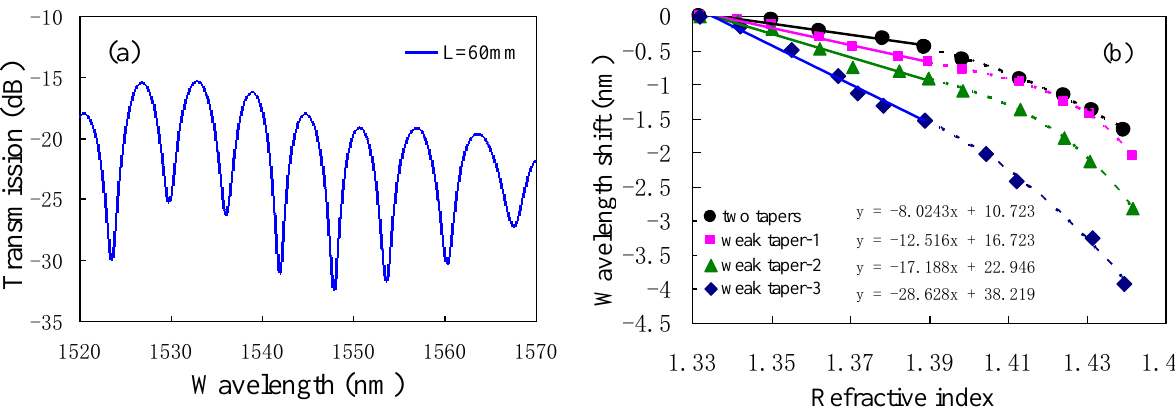
Figure 8. The three-tapers-based MZIs: ( a ) the transmission spectra with interaction length L of ~60 mm; ( b ) the RI sensitivities with different weak